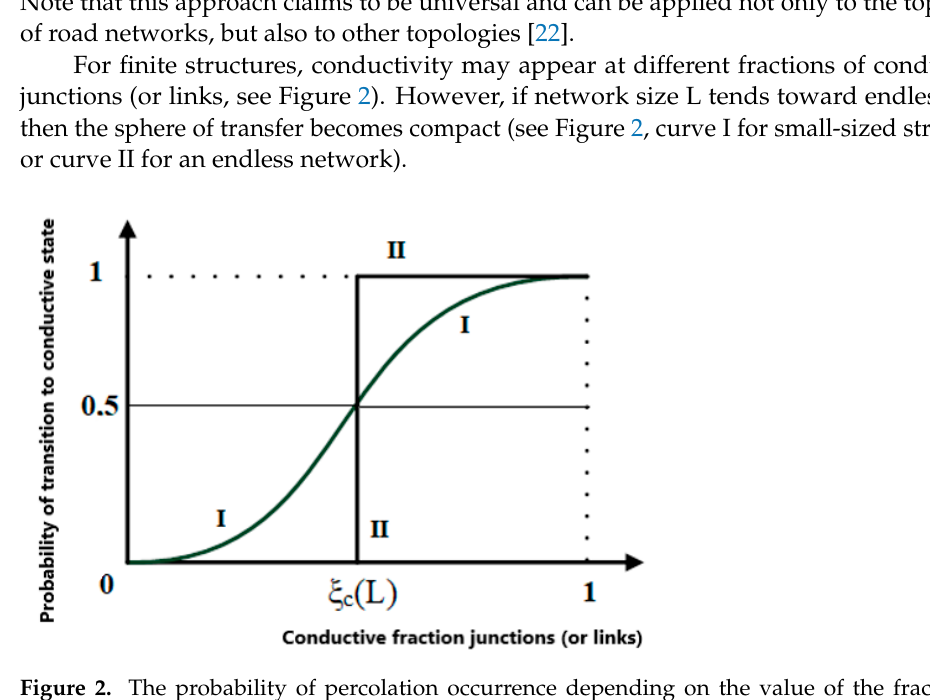
Figure 2. The probability of percolation occurrence depending on the value of the fraction of conductive junctions (or links).